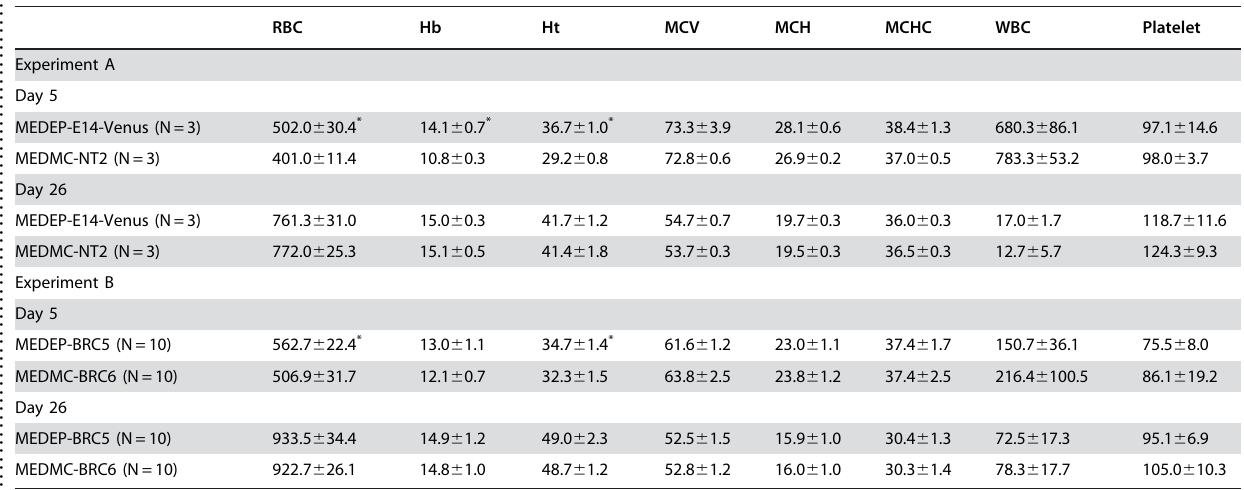
Table 3. Blood count after induction of acute anemia and cell transplantation. .. ... .... ... ... .... ... ... .... ... ... .... ... ... .... ... ... .... ... ... .... ... ... .... ... ... .... ... ... .... ... ... .... ... ... .... ... ... .... ... ... .... ... ... . RBC